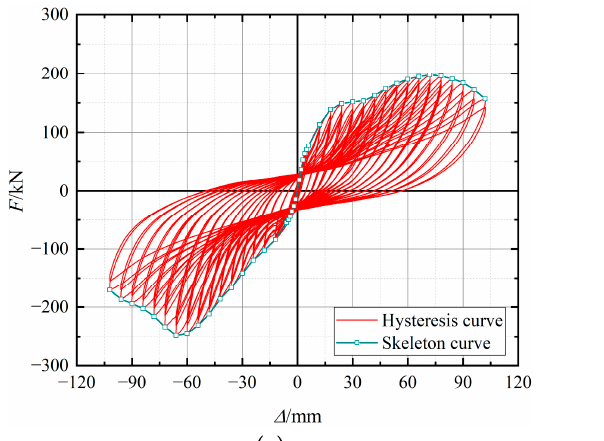
the steel frame of WP-1 was damaged, while the connecting weld of the WP-2 test piece